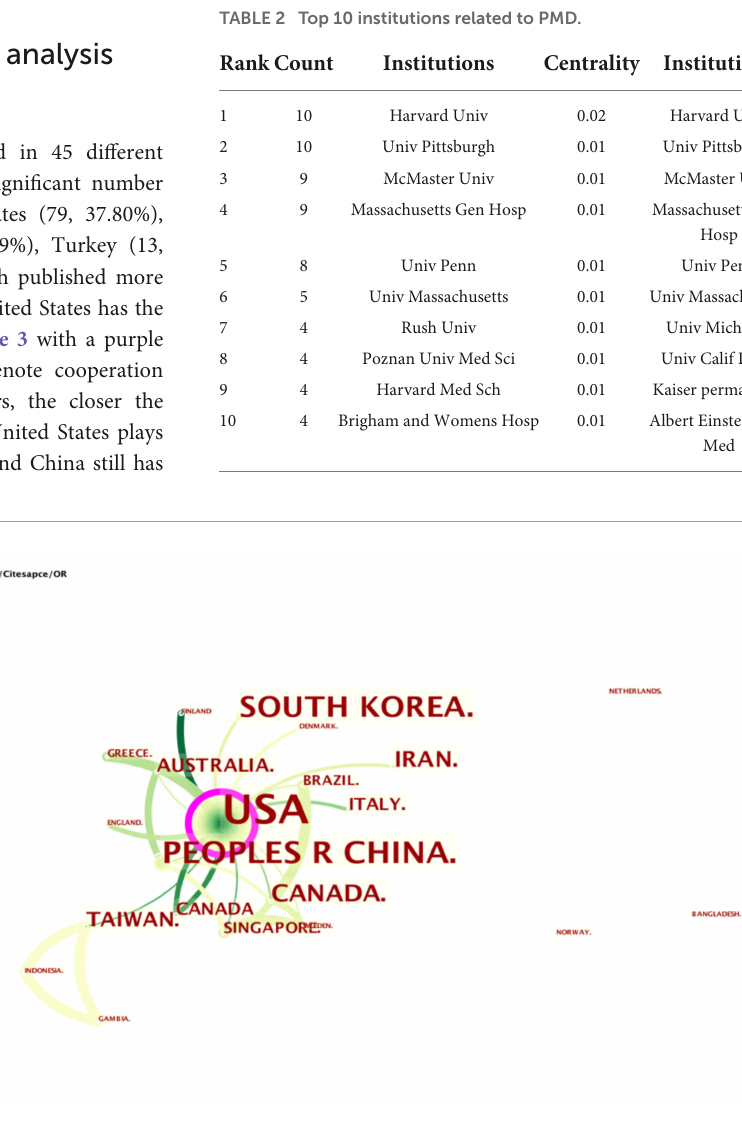
FIGURE3 Distribution of publications from different